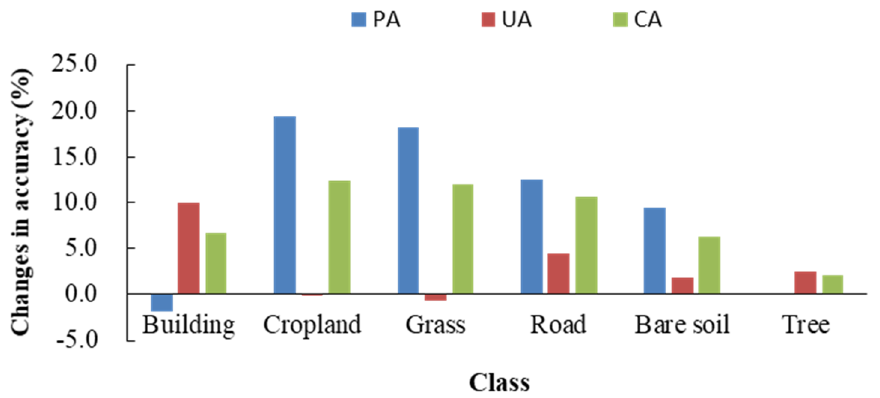
Figure 16. Net changes of classification accuracy of single type of between LiDAR (cid:1835)(cid:1866)(cid:1872)(cid:1857)(cid:1866)(cid:1871)(cid:1861)(cid:1872)(cid:1877) (cid:3004)(cid:3045)(cid:3032)(cid:3033) and LiDAR (cid:1835)(cid:1866)(cid:1872)(cid:1857)(cid:1866)(cid:1871)(cid:1861)(cid:1872)(cid:1877) (cid:3004)(cid:3028)(cid:3040)(cid:3043) .